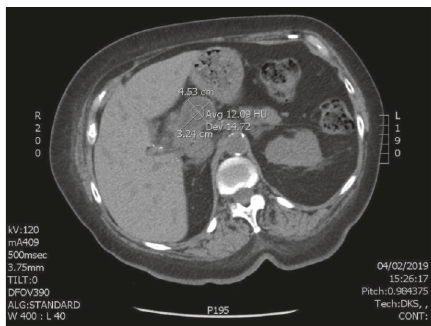
Figure 1: CTscan image of the abdomen without contrast showing the pancreatic mass before treatment.